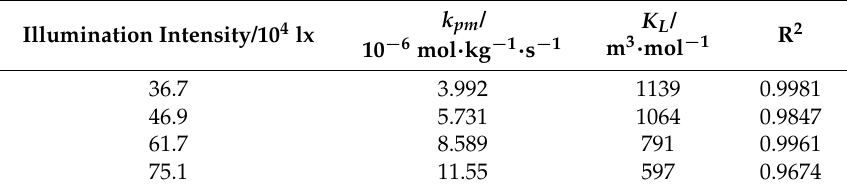
Figure 3. Plots of ln( c 0 / c )/( c 0 − c ) vs. t /( c 0 − c ) under different illumination intensity. (solid points: experimental results; solid line(curve): fitted results). Table 1. Calculated K pm and K L under different illumination intensity using the original L-H model.